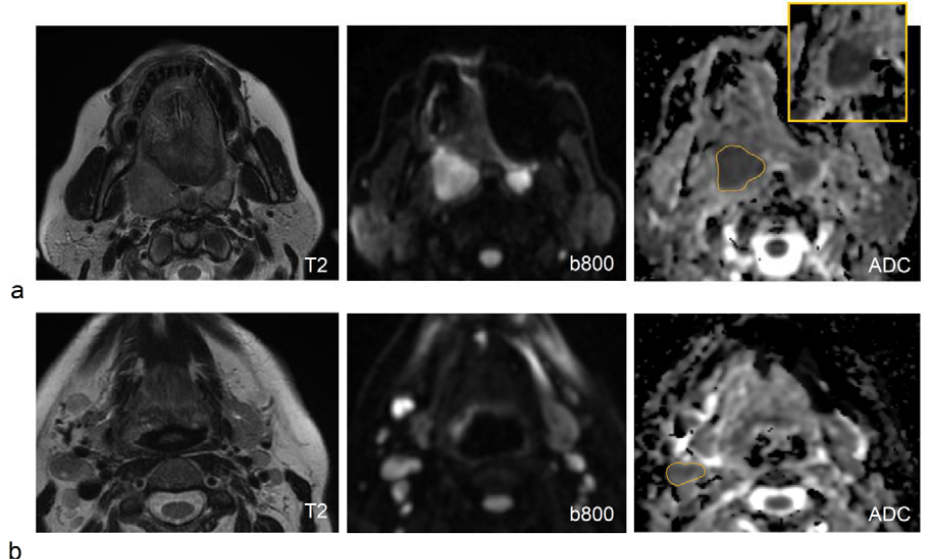
Figure 4. HPV-positive OPSCC in a 57-year-old non-smoker non-alcoholic female, correctly classified by all the proposed models. MRI shows a lesion in the right palatine tonsil, characterized by a homogeneous and moderate signal intensity on the T2-weighted image and a hyperintense signal on DWI obtained with b = 800 s/mm 2 . Consistently, both ADC and D maps (the latter was cropped in the upper right yellow box) indicate strongly decreased values in the user-defined lesion contour (yellow line), with 50th percentiles of 0.87 × 10 − 3 mm 2 /s and 0.76 × 10 − 3 mm 2 /s, respectively ( a ). Bottom: the same patient had a pathological lymph node at the right IIa level, showing a homogeneous signal intensity on the T2-weighted image, a mildly hyperintense signal on the DWI obtained with b = 800 s/mm 2 , and intermediate and uniform values on the ADC map (yellow line), with an Inverse Difference Moment of ADC LN equal to 0.46 ( b ).